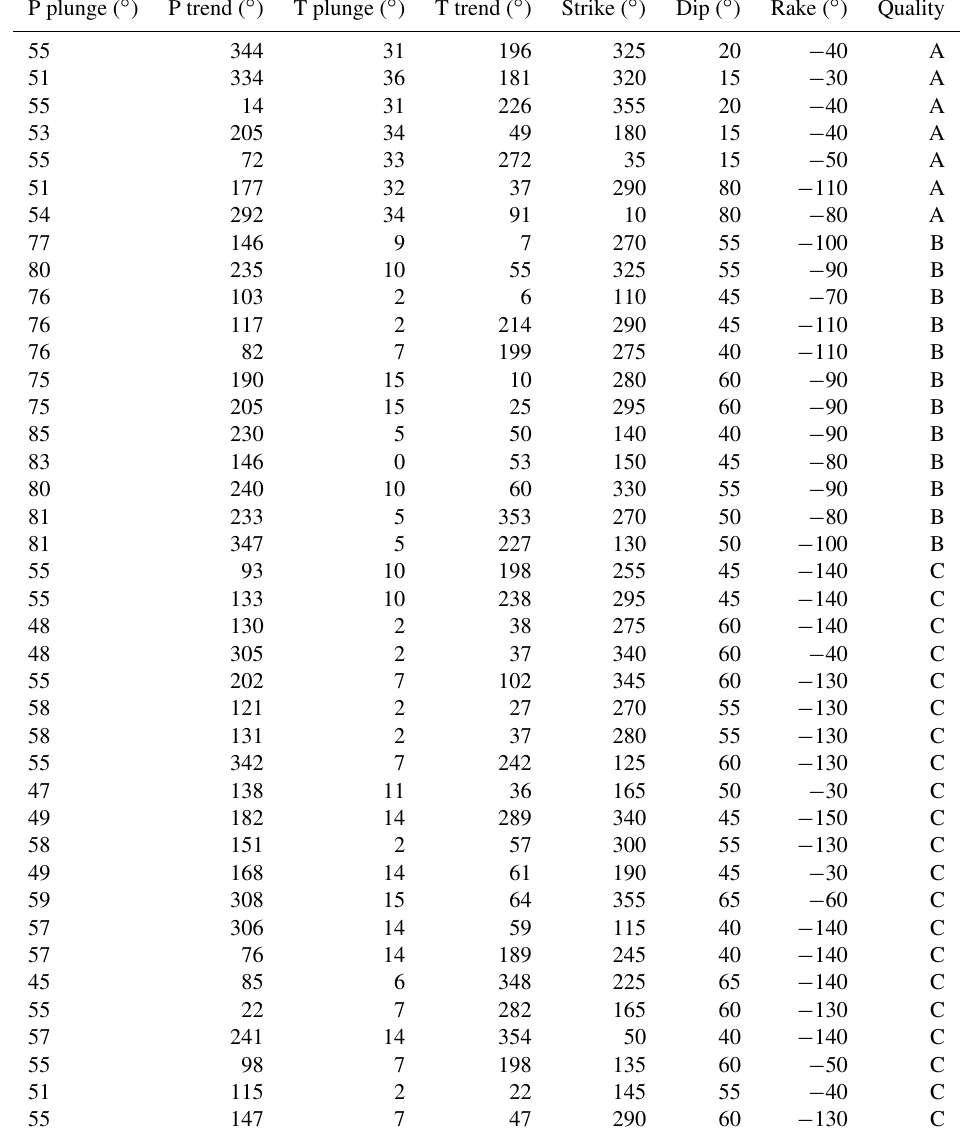
Table 3. Fault plane solutions of instrumental seismicity that occurred in the Irpinia region in 2005–2008 and calculated by De Matteis et al. (2012). The solutions are classified according to a quality code based on the resolution of fault plane kinematics as derived in this study. The result of our simulations suggests a quality as follows: FM1: C; FM2: B; FM3: